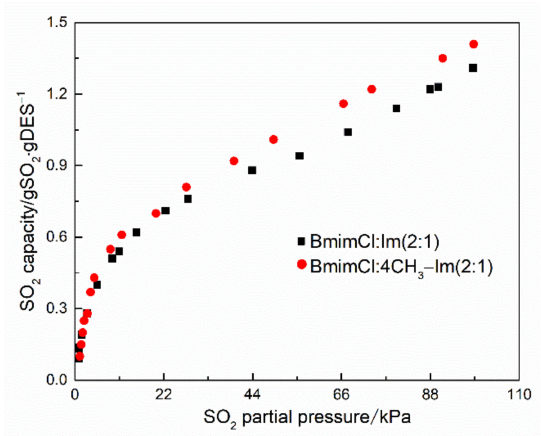
Figure 3. Effect of SO 2 partial pressure on the SO 2 capture at 293.2 K (Reprinted with permission from Ref. [52]. Copyright (2018) American Chemical